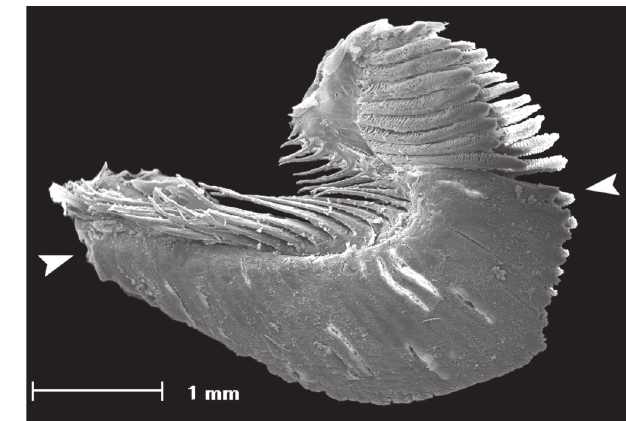
Fig. 7. Macropsobrycon uruguayanae , mature male, MCP 11939, 34.2 mm SL; Scanning Electron Micrograph (SEM) of the first gill arch left side, showing the gill gland delimited by the arrows head.